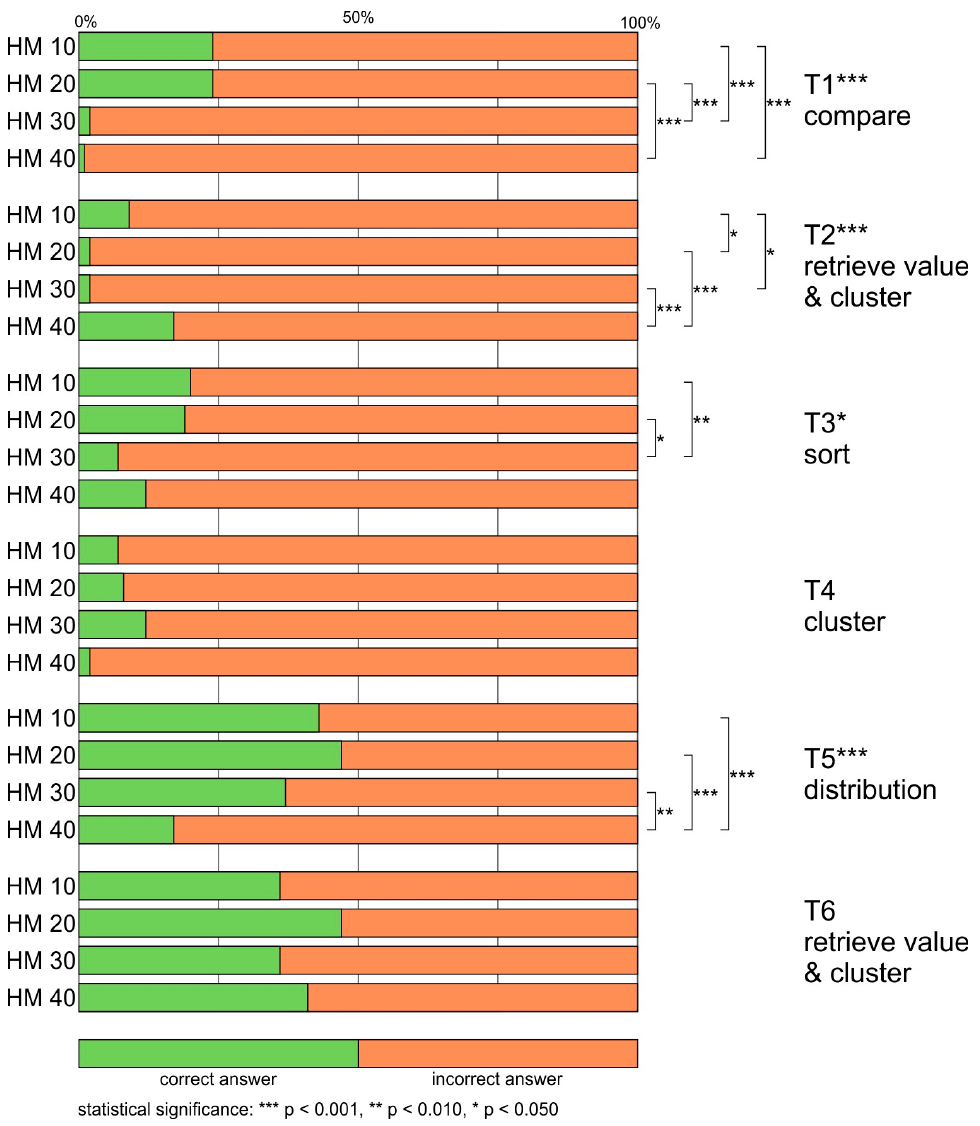
Figure 4. Differences in answer accuracy between participants using the four tested heat maps.